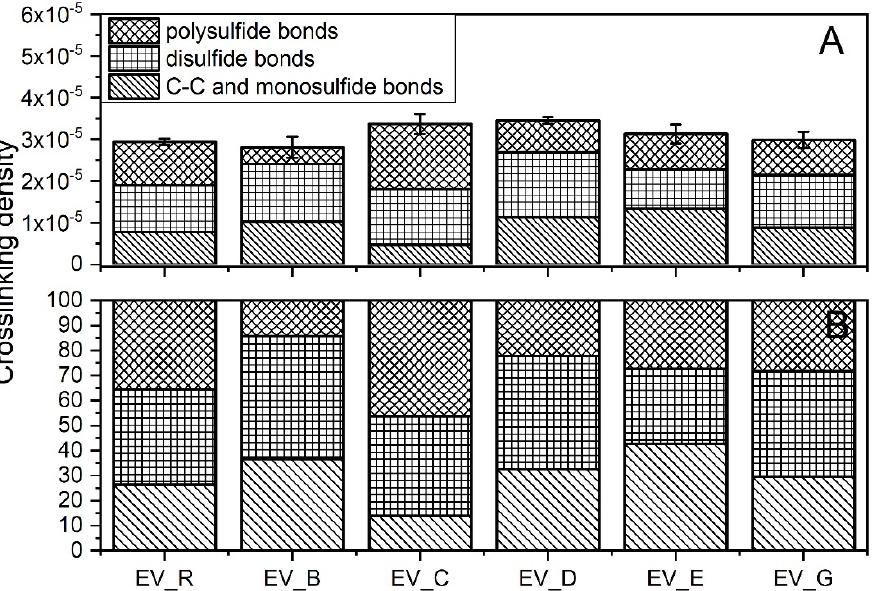
Figure 7. Crosslink structure of rubber compounds produced in the EV system: ( A ) content of crosslinks (mole/cm 3 ); ( B ) division of crosslinks (%). EV_...—rubber compounds containing n-ZnO in the effective curing system; EV_R—reference rubber compound containing standard ZnO in the effective curing system.